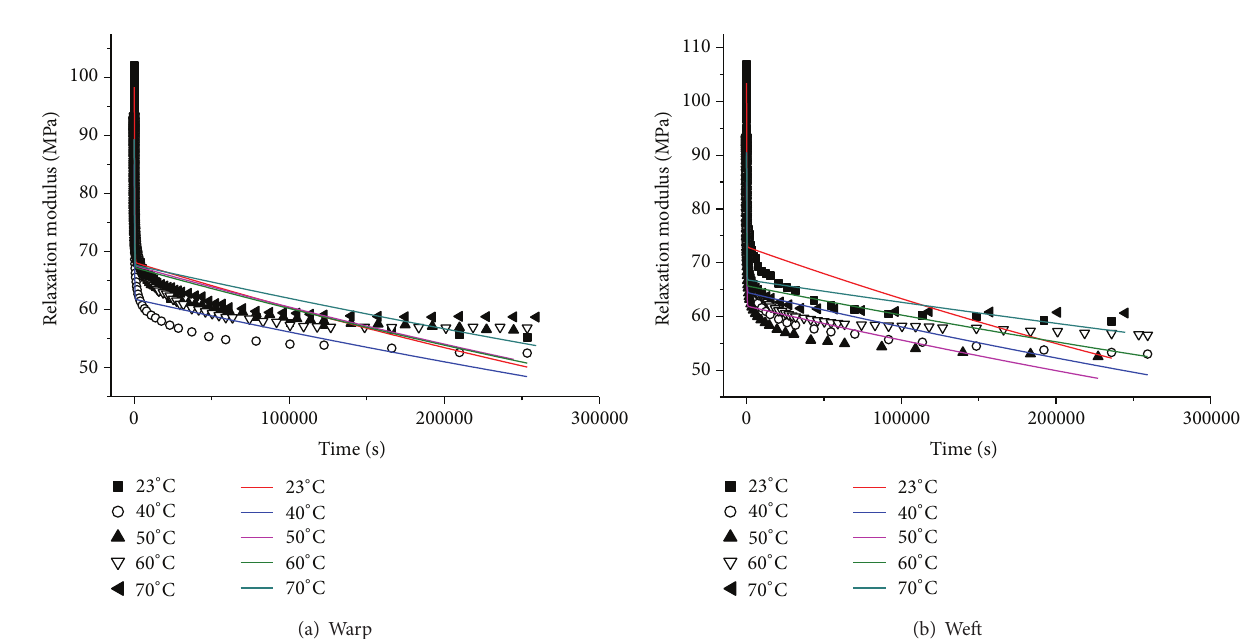
Figure 13: Prediction of the fractional exponential model.